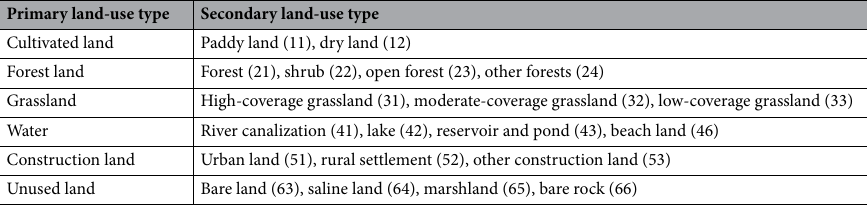
Table 1. Land use classification